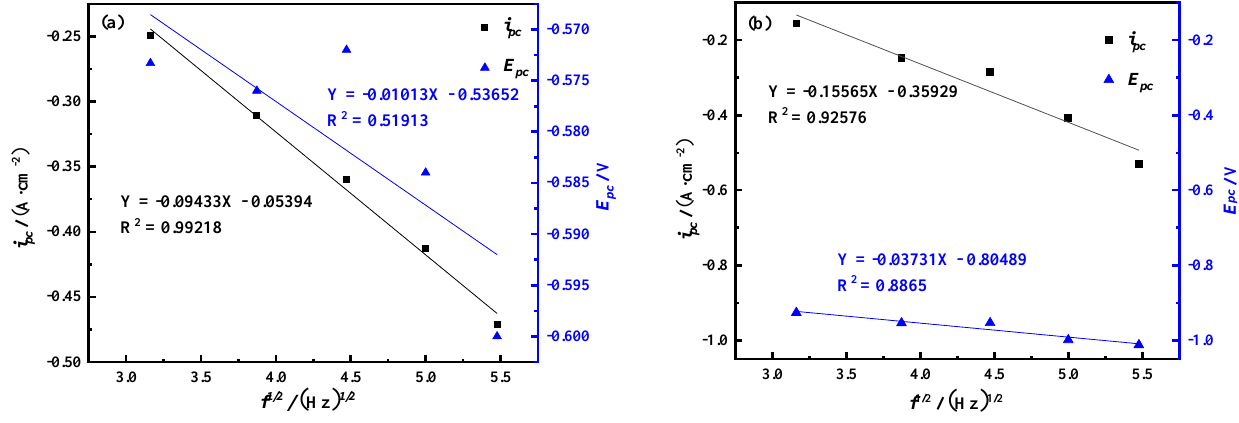
Figure 5. Curves of reduced peaks i pc - f 1/2 and E pc - f 1/2 ( a ) peak C ( b ) peak B. Peak B was fitted according to the square wave voltammetry, as shown in Figure 6. B is n = 2.06, calculated from Formula (1), which is about equal to n = 2, and the number of